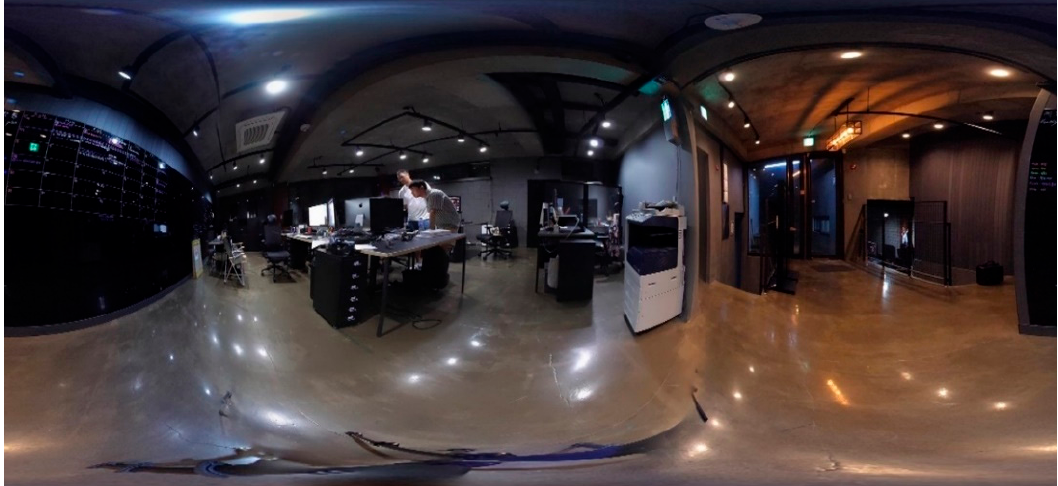
Figure 10. The Left-view stereo panorama created by our proposed system.